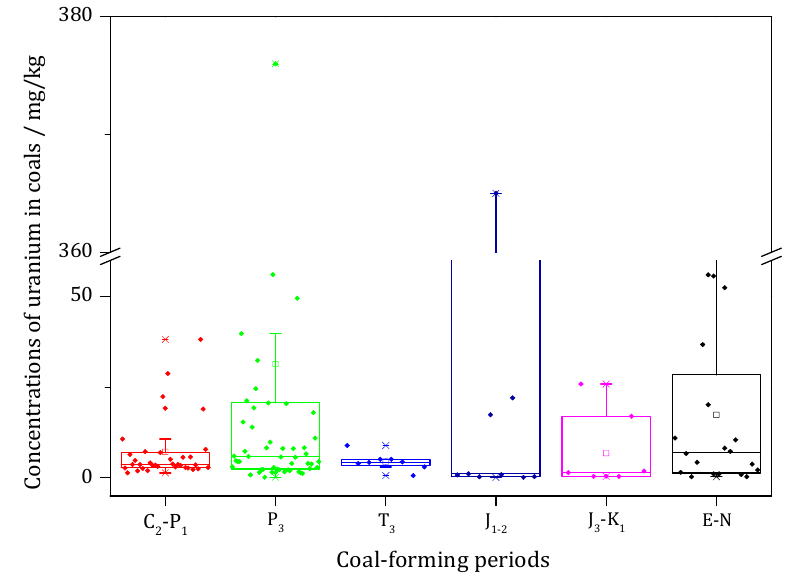
Figure 4. Variation of uranium concentrations in Chinese coals of different coal-forming periods. C 2 -P 1 : Late Carboniferous and Early Permian; P 3 : Late Permian; T 3 : Late Triassic; J 1-2 : Early and Middle Jurassic; J 3 -K 1 : Late Jurassic and Early Cretaceous; E-N: Paleogene and Neogene.